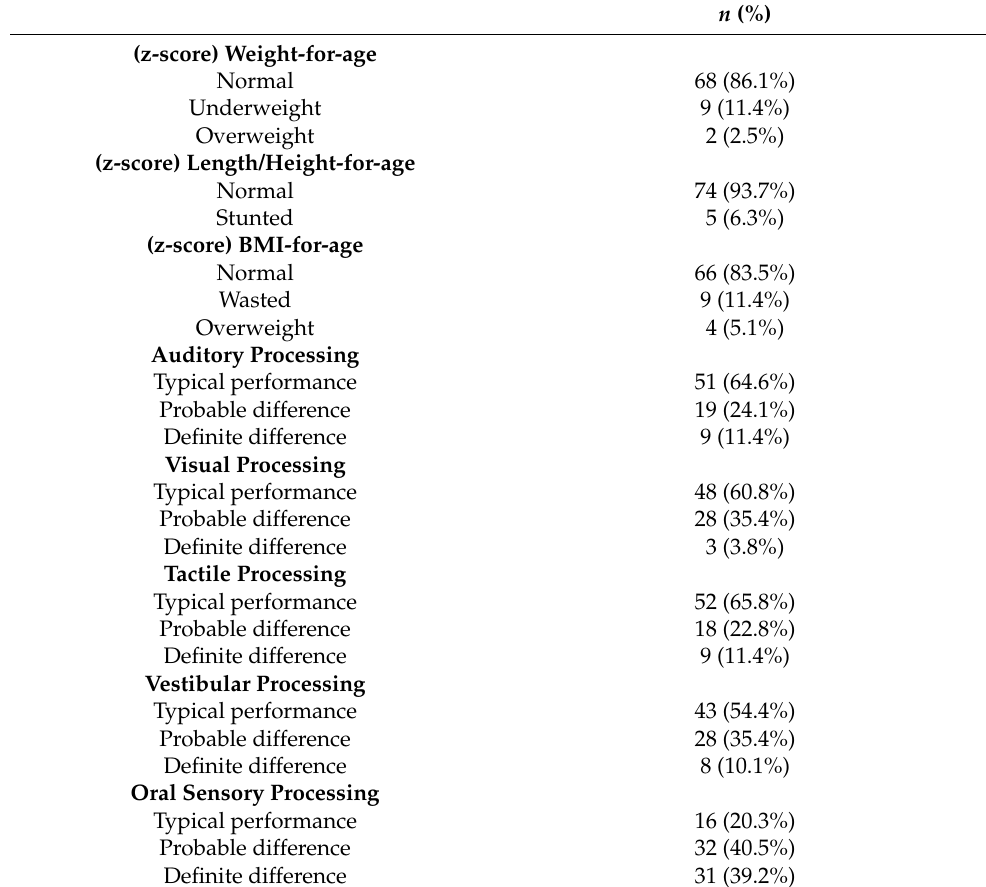
Table 1. Anthropometric and sensory processing characteristics of the